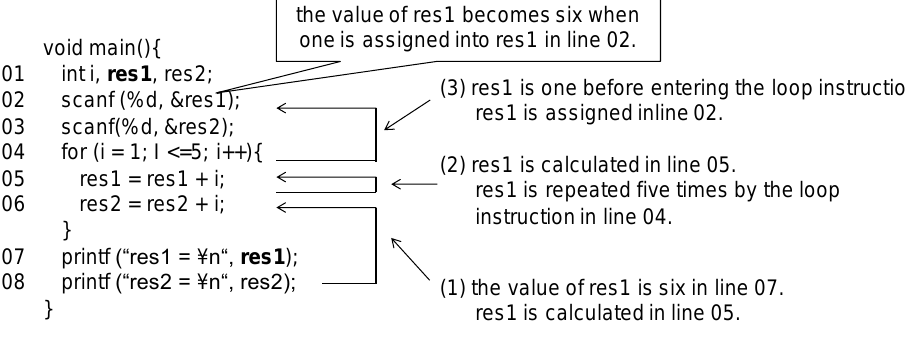
Figure 5. The procedure of the proposed fault tree analysis (FTA). Second, we explain the FT templates. In the proposed method, we develop the FT templates. The FT templates are developed based on the result of the appearance fre- quency of the instructions in the existing twenty CSWs. Figure 6a – i shows each FT tem- plate. These FT templates are described using logical symbols. In each FT template, it only shows the relationship between the event after the execution of an instruction (TE- vent) and the event before the execution of that instruction (BEvent). Figure 6a shows the FT template for the assigned statement. This template explains that the causes of the undesirable event are the case of “ input value is incorrect ” or the case of “ operator is in- correct ” when this instruction is executed. Figure 6b shows the FT template for the if-then-else statement. This template explains that the causes of the undesirable event are the case that “ n-th clause is executed and the instruction in the clause produces the event ” or the case that “ else clause is executed and the instruction in the clause produces the event ” when this instruction is executed. Figure 6c shows the FT template for the whole statement. This template explains that the causes of the undesirable event are the case that “ as a result of not executing this instruction, the undesirable events occur ” or the case that “ as a result of executing this instruction n-th times, the undesirable event occurs ” when this instruction is executed. Figure 6d shows the FT template for the func- tion call. This template explains that the cause of the undesirable event is the case that “ arguments are incorrect ” or the case that “ the function cannot be executed ” when this instruction is executed. Figure 6e shows the FT template for interruption. This template explains that the causes of the undesirable event are the case that “ the interruption oc-